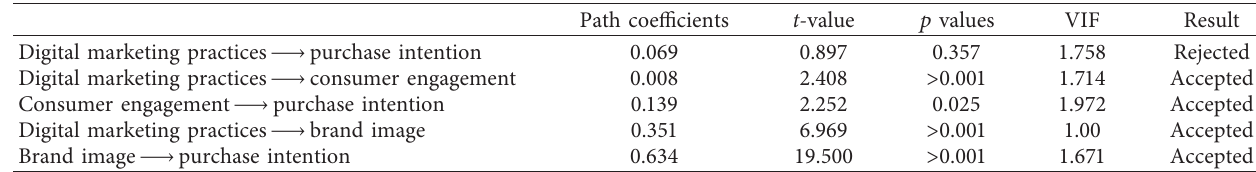
Table 9: Path coefficients and p values.